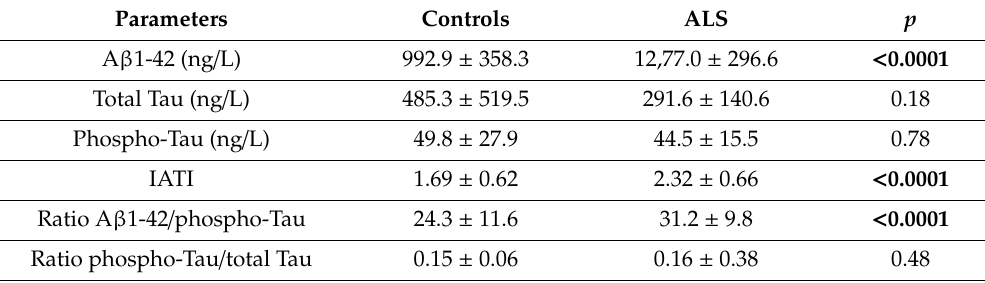
Table 2. Biomarker levels in the CSF from controls and ALS patients.